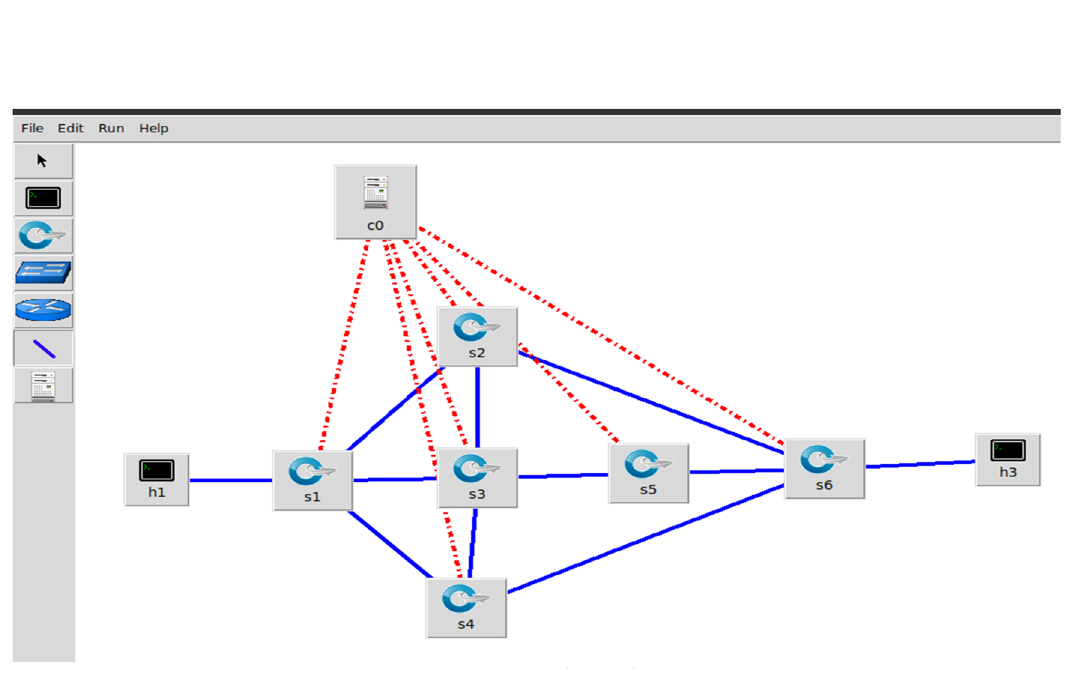
Figure 7: Network topology